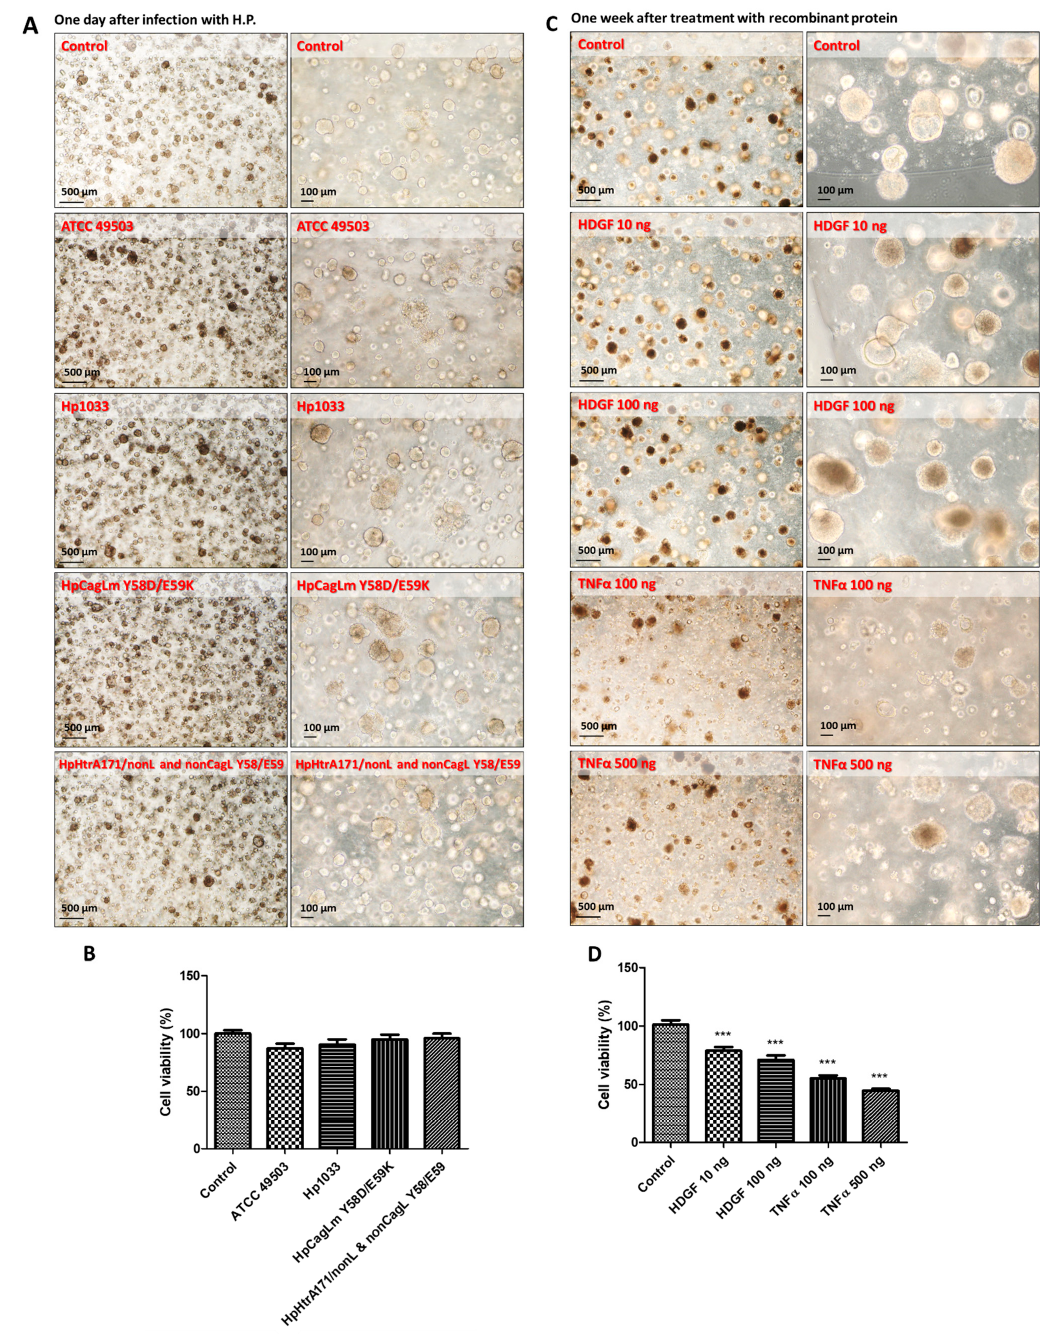
Figure 2. Cultivation of organoids after infection with various H. pylori species and examination of their viabilities. ( A ) The morphologies and growth of the gastric organoid HCM-BROD-0045-C16 for 1 day after infection with various H. pylori such as ATCC 49503, Hp1033, HpCagLm Y58D/E59K, and HpHrtA171/nonL and nonCagL Y58/E59 strains. ( B ) Cell viability of human gastric cancer organoids with infection by various H. pylori as described above. ( C ) The morphologies and growth of the gastric organoids HCM-BROD-0045-C16 for 7 days in the presence of indicated doses of HDGF and TNF α after infection with various H. pylori such as ATCC 49503, Hp1033, HpCagLm Y58D/E59K, and HpHrtA171/nonL and nonCagL Y58/E59 strains. ( D ) Cell viability of human gastric cancer organoids cultured for one week in the presence of indicated doses of recombinant HDGF or TNF α . The recombinant proteins were homogenous (ref. [12] or 300-01A, PeproTech, Cranbury, NJ, USA). *** indicates p < 0.005 ( n =